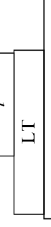
Fig. 2. The energy band diagram of the control heterostructure of the photodetector with the controlled relocation of carrier density